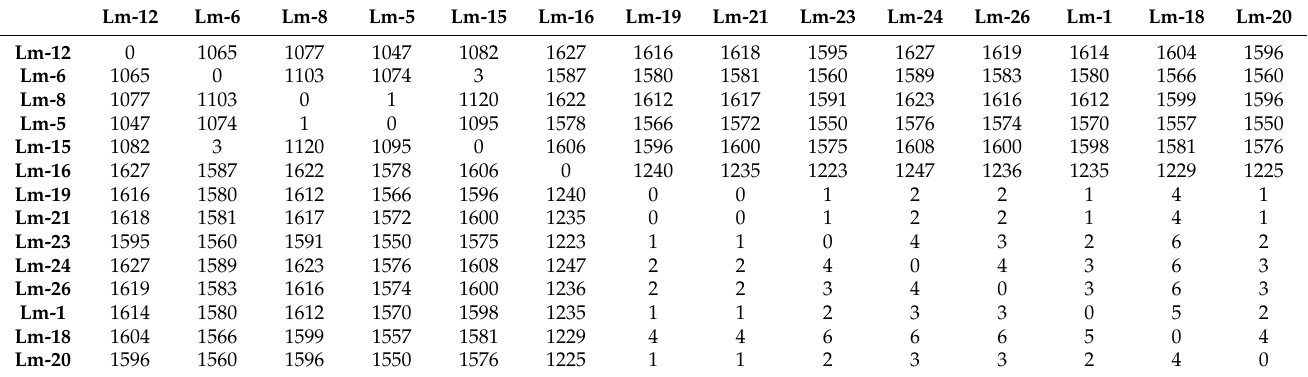
Table 4. Allelic distance detected among each pair of strains of the fourteen L. monocytogenes isolates.